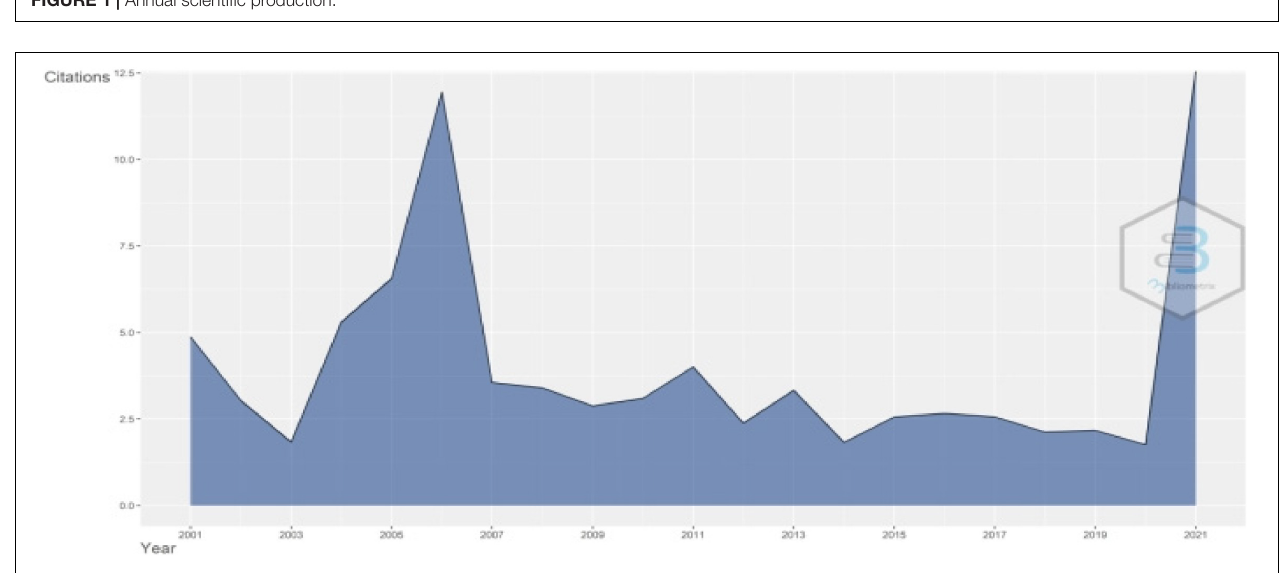
FIGURE 2 | Average citation per